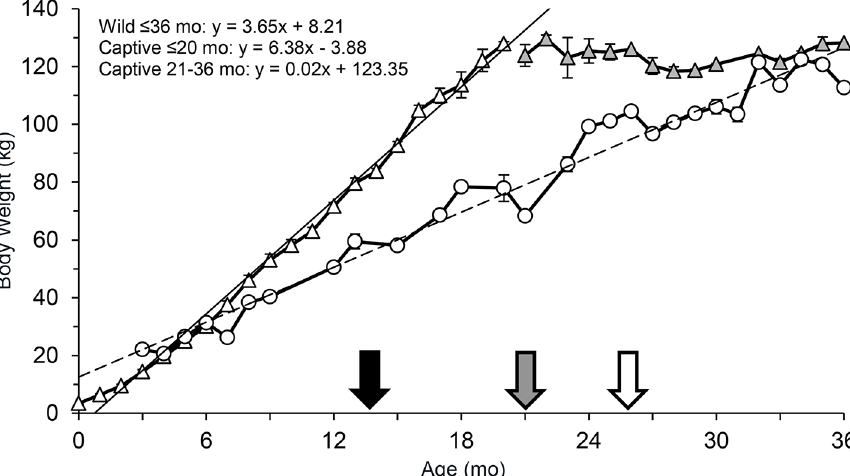
Fig 8. Monthly average ( ± SE) body weights (kg) of captive (triangles) and wild (circles, adapted from Smuts et al. (1980)) female lions through 3 yr (36 mo). White triangles denote months when captive females were actively gaining weight and grey triangles represent months where the average body weight was similar to adult weights. Trend lines are solid for captive lions and dashed for wild lions. The black arrow indicates the average age, 13 mo (1.06 yr), and body weight, 80 kg at which captive females (n = 4) showed waves of follicular development. The grey arrow approximates when wild lions should begin cycling based on the age, 21 mo (1.75 yr), at which they reach ~80 kg and the open arrow is the estimated age (26 mo, 2.2 yr) and body weight (96 kg) when females reach puberty in the wild using behavioral observations (Smuts,